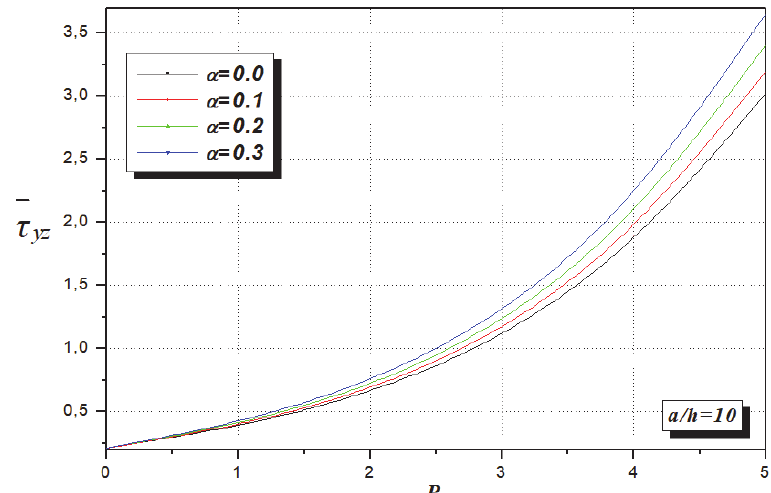
 as a function of the power index P and the different porosity factor α yz